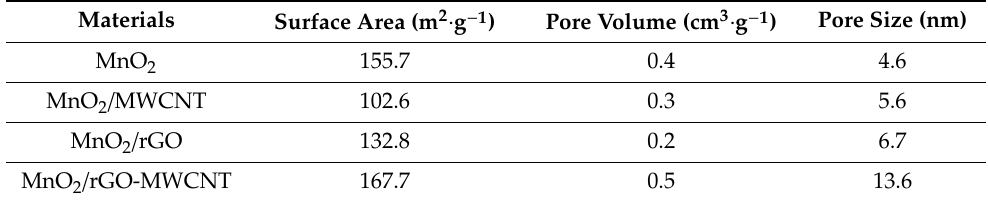
Table1. ThepowderpropertiesofMnO 2 ,MnO 2 / MWCNT,MnO 2 / rGOandMnO 2 /